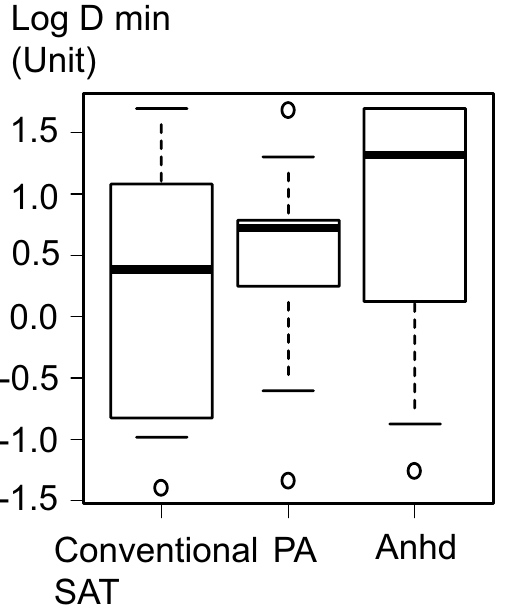
Figure 1. Log10-transformed D min of each CholU subtype. Anhd acquired anhidrosis and/or hypohidrosis, D min cumulative dose of inhaled methacholine when respiratory resistance began to increase, PA palpebral angioedema, SAT sweat allergy type, Anhd acquired anhidrosis and/or hypohidrosis.